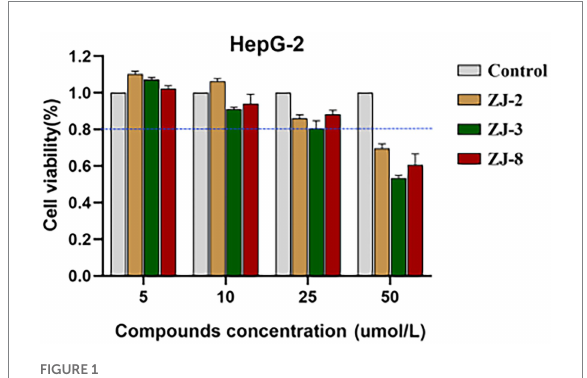
FIGURE 1 Cell viability assay of diarylureas to HepG-2